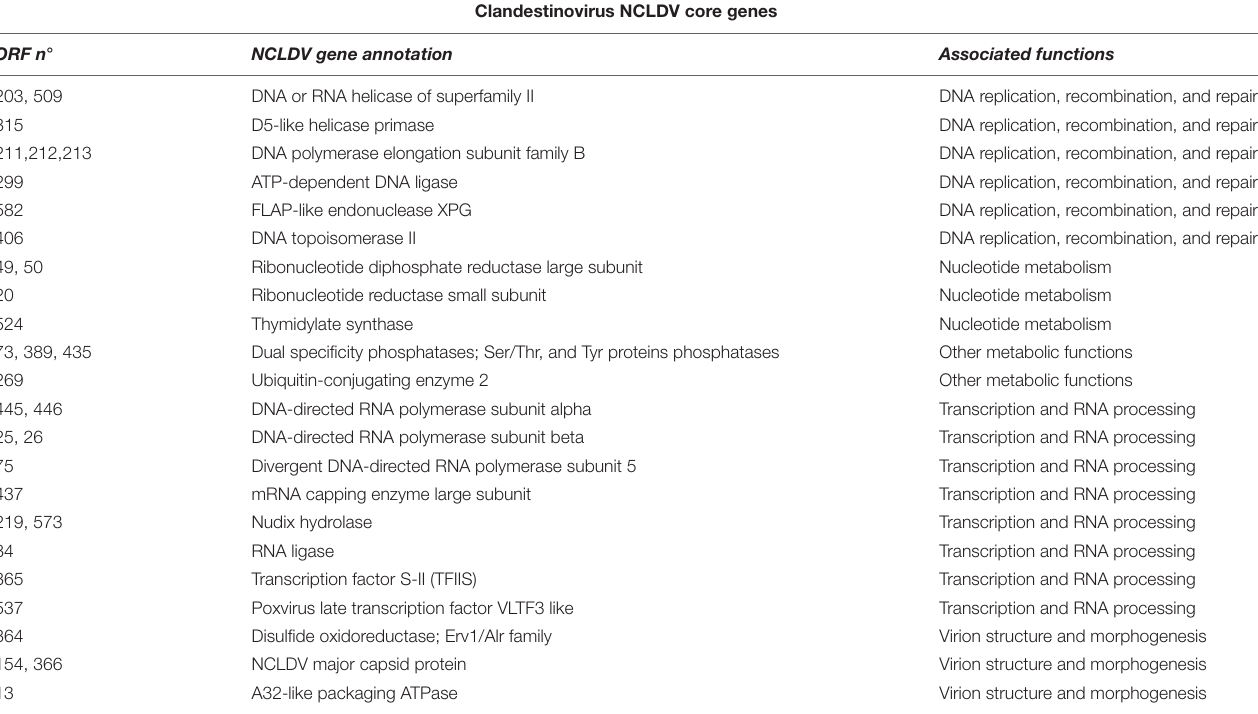
TABLE 2 | Nucleo-cytoplasmic large DNA viruses (NCLDV) core genes in the clandestinovirus genome. Clandestinovirus NCLDV core